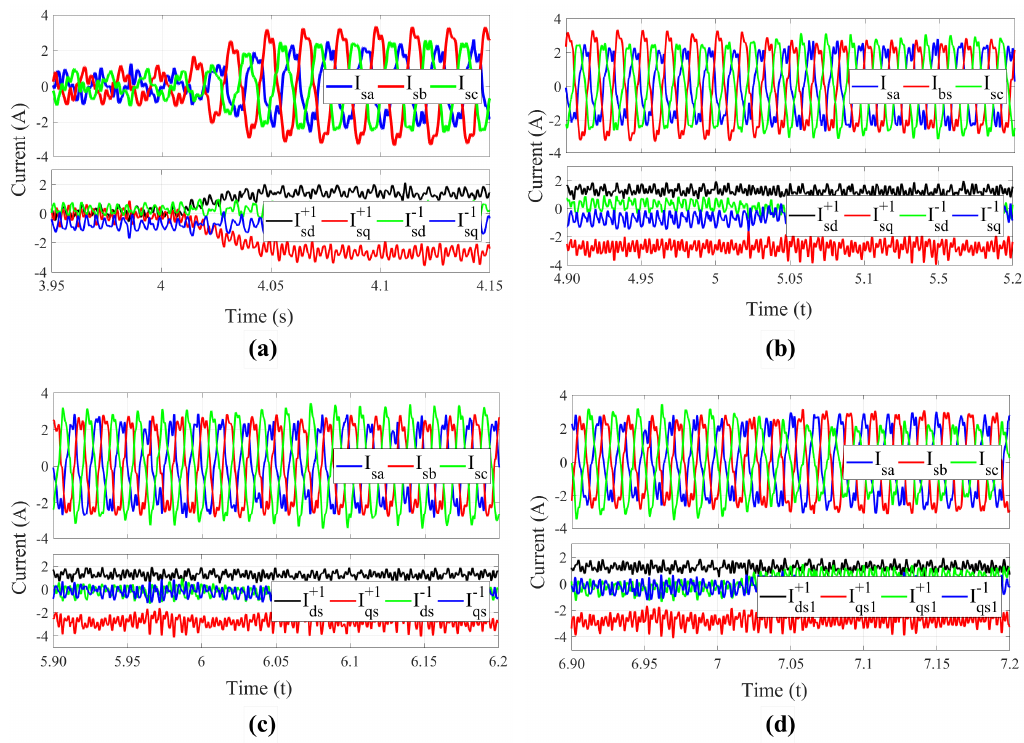
Figure 9. Evolution of the stator currents (A) when changing from: ( a ) regular control strategy (no compensation to address the voltage imbalance) to Objective I; ( b ) Objective I to Objective II; ( c